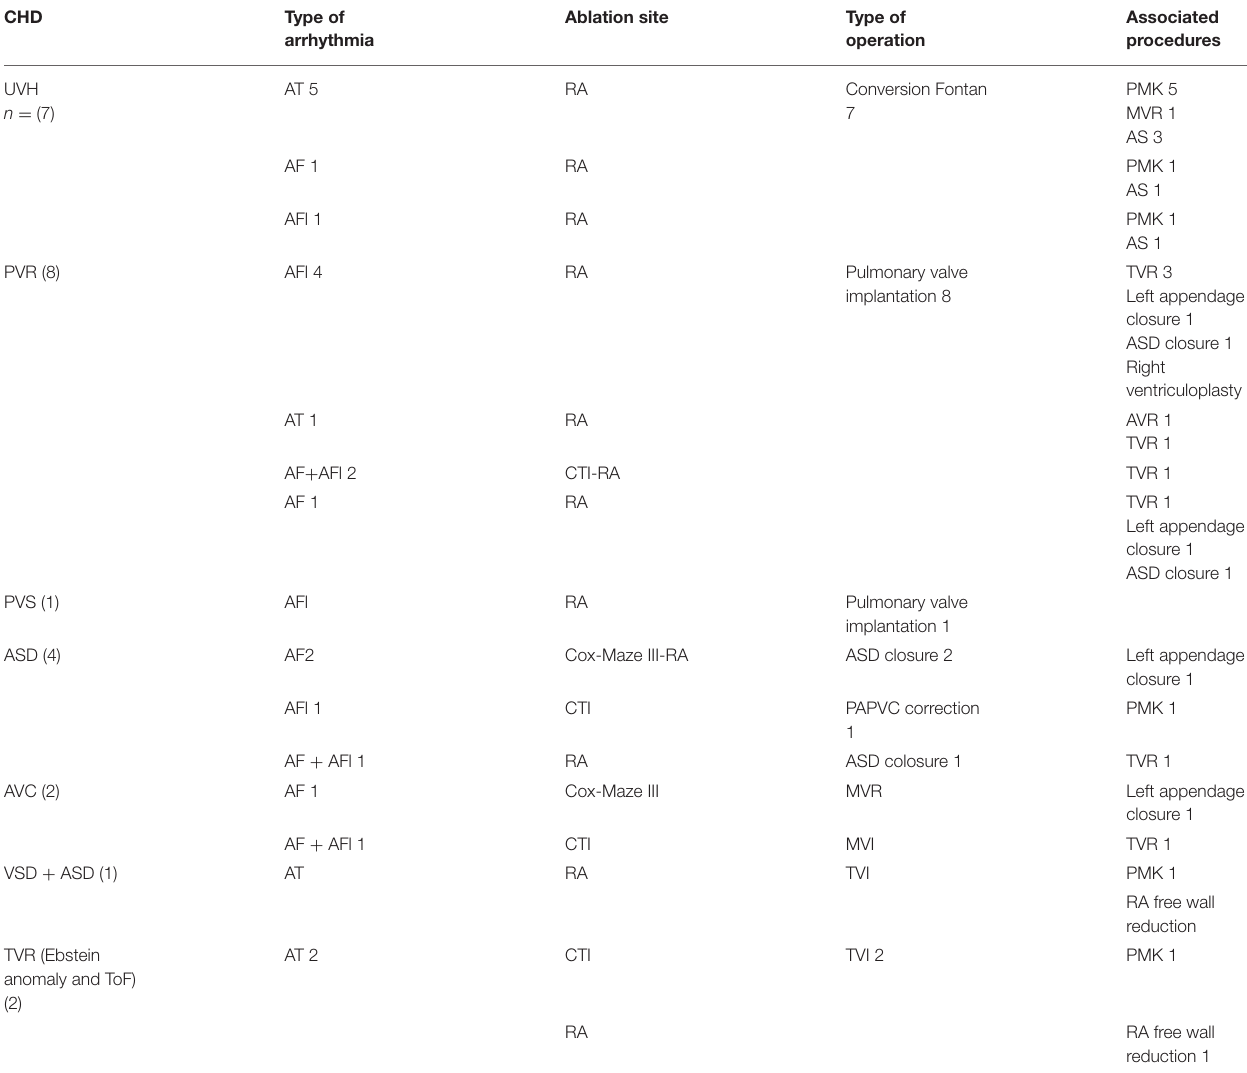
TABLE 2 | Type of arrhythmia and surgical